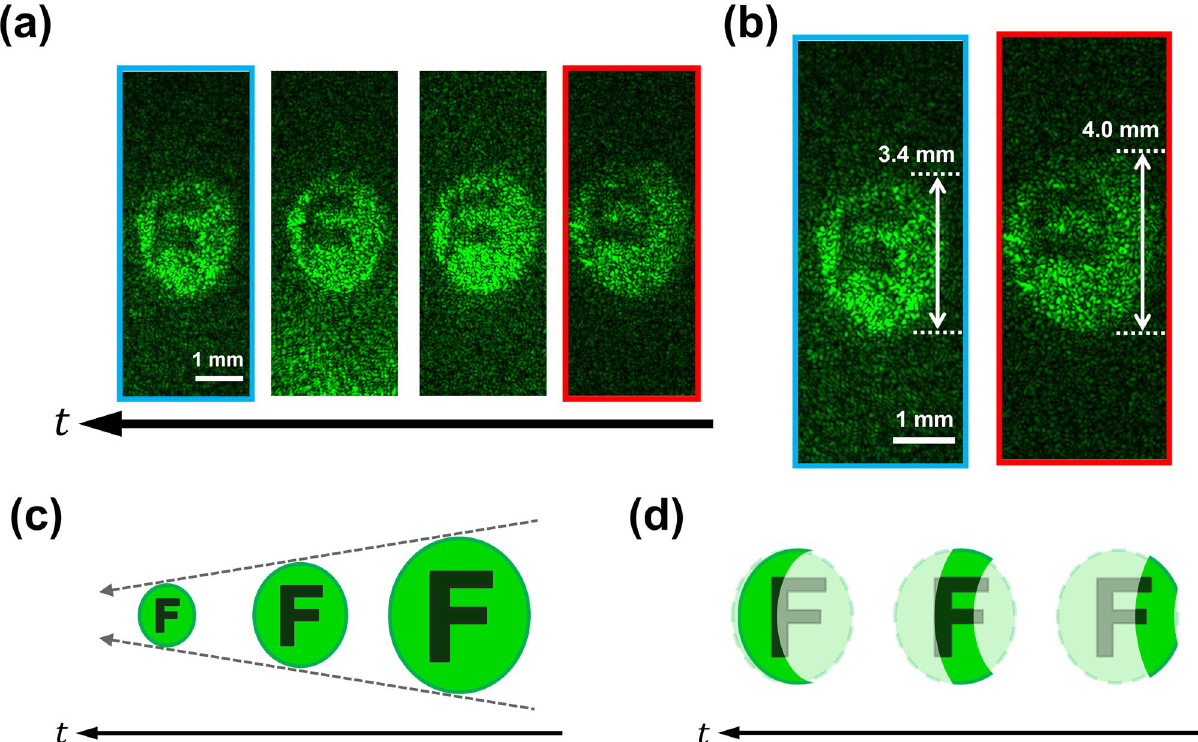
Figure 7. Experimental results and schematic illustration of the difference in experimental results. ( a ) Experimental results. The pulse surface was structured by the amplitude mask in which was printed the letter “F”. ( b ) Two frames extracted from the reconstructed images of the light pulse. ( c ) A schematic illustration of a behaviour of the reconstructed image when the light pulse itself was recorded. ( d ) A schematic illustration of a behaviour of the reconstructed image when the image of the area where the illumination light pulse illuminated the diffuser plate was